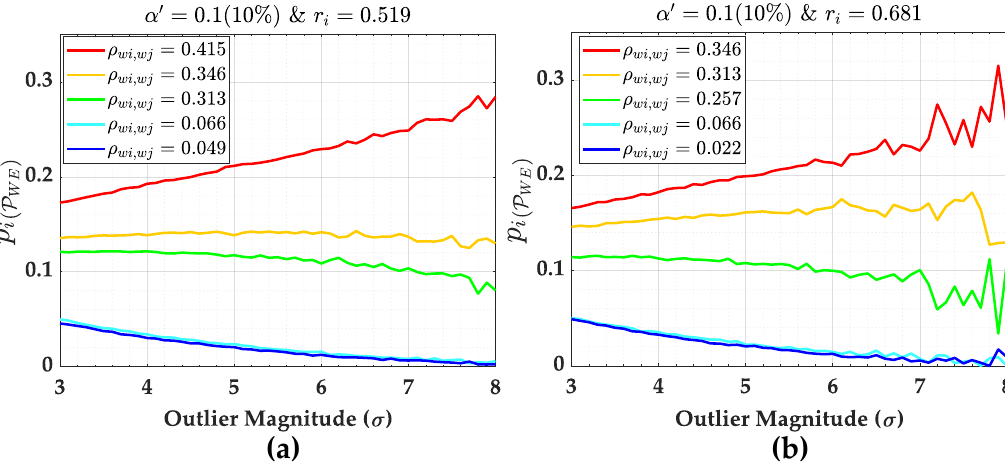
Figure 13. Weighting factors p i ( P external connections. ( b ) Weighting factors p i ( P